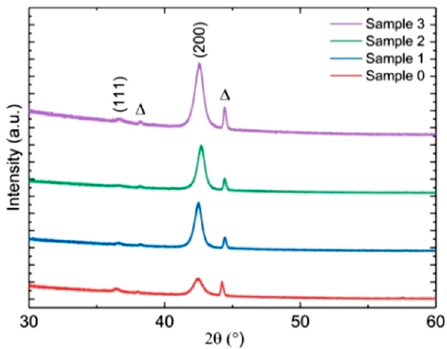
Figure 13. XRD patterns of Samples 0–3 in the range 30–60°, where ∆ represents the background peak.